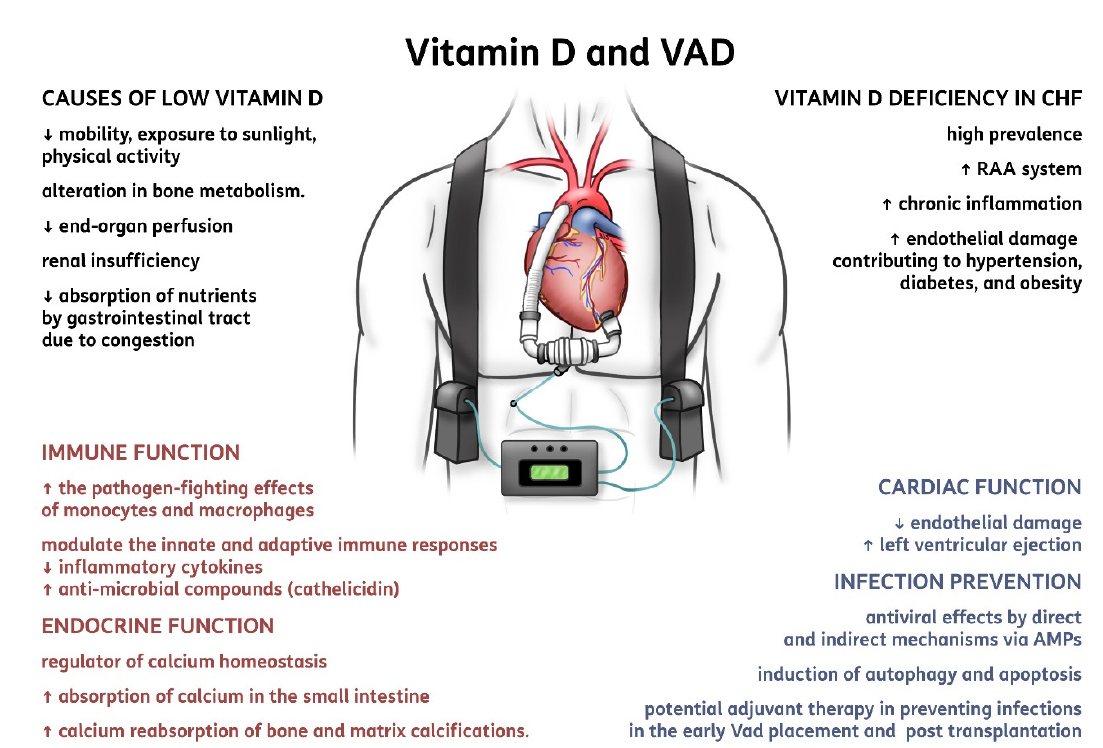
Figure 2. Summary of vitamin D implications in ventricular assist devices. Abbreviations: CHF, chronic heart failure; RAA system, renin-angiotensin-aldosterone system; VAD, ventricular assist device; AMPs, anti-microbial peptides.